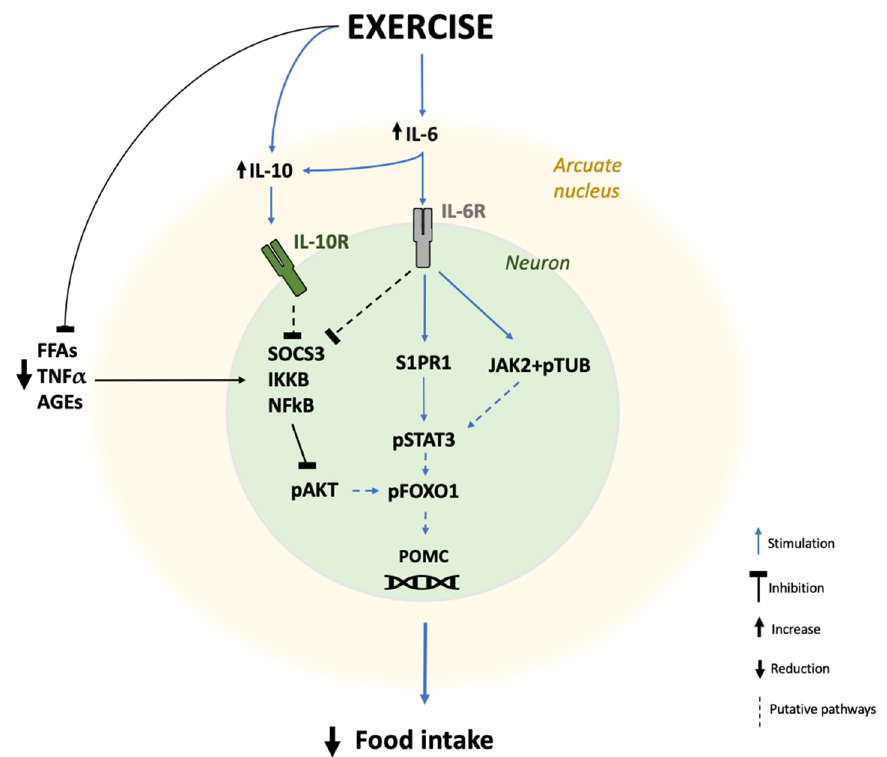
Figure 2. Potential pathways underlying the effect of exercise in restoring insulin and leptin and insulin sensitivity in the hypothalamus of obese animals and humans. Exercise-induced suppression of inflammatory mediators (e.g., FFAs, AGEs, TNF α ), along with IL-6 and IL-10 increase, downregulate the inflammatory signalling, with positive effects on the insulin pathway. Exercise-induced IL-6 restores the leptin signalling (JAK2, pSTAT3), via activating S1PR1 and TUB, with the final effect of stimulating the transcription of POMC. AGEs, advanced glycation endproducts; AKT, protein kinase B; Foxo1, Forkhead box protein O1; IL, interleukin; JAK2, Janus kinase 2; IKKB, inhibitor of nuclear factor kappa-B kinase subunit beta; NF- κ B, nuclear factor kappa-light-chain-enhancer of activated B cells; POMC, pro-opiomelanocortin; S1PR1, sphingosine-1-phosphate receptor 1; SOCS3, suppressor of cytokine signaling 3; STAT3, Signal transducer and activator of transcription 3; TNF α , tumor necrosis factor- α .